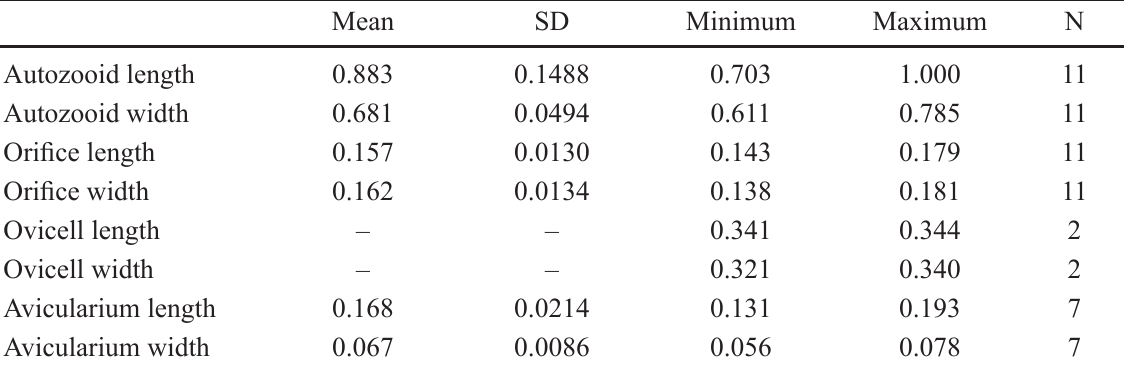
Table 4. Measurements (in mm) of Rhynchozoon confusum (Calvet, 1906) comb. nov. (lectotype and paralectotypes). SD = standard deviation; N = number of